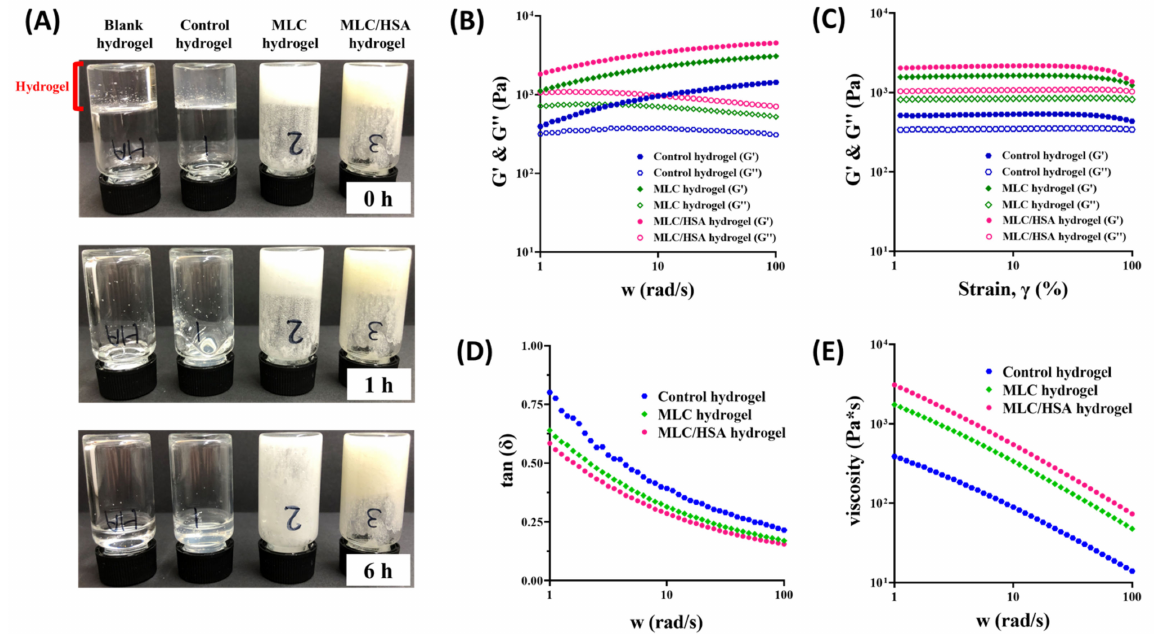
Figure 4. Rheological analyses of the MLC/HSA hydrogel. ( A ) Appearance of the hydrogels in the inverted vials observed immediately after inversion, as well as after 1 h and 6 h. ( B ) Storage modulus (G (cid:48) ) and loss modulus (G (cid:48)(cid:48) ) as the function of angular frequency (w) at 1% strain ( γ ), and ( C ) G (cid:48) and G (cid:48)(cid:48) as the function of strain sweep at the frequency of 2 rad/s. ( D ) Calculated dissipation factor (tan δ ) as the function of angular frequency at 1% strain. ( E ) Viscosity (Pa • s) of the hydrogels measured by varying the angular frequency at 1%